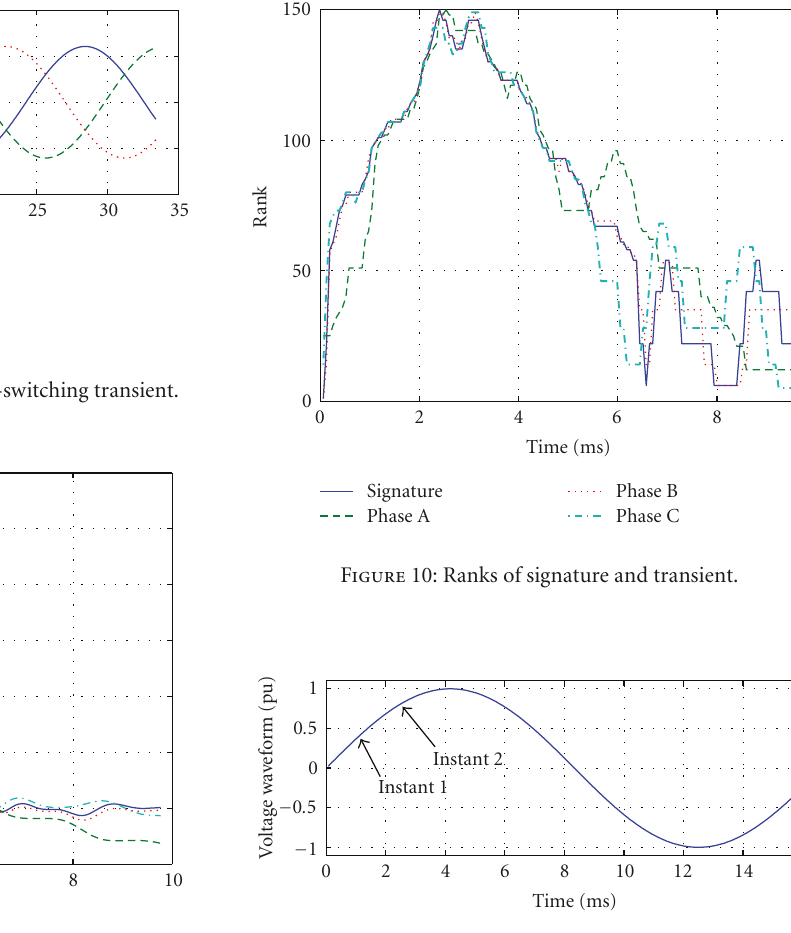
Figure 11: Switching instants on phase A voltage